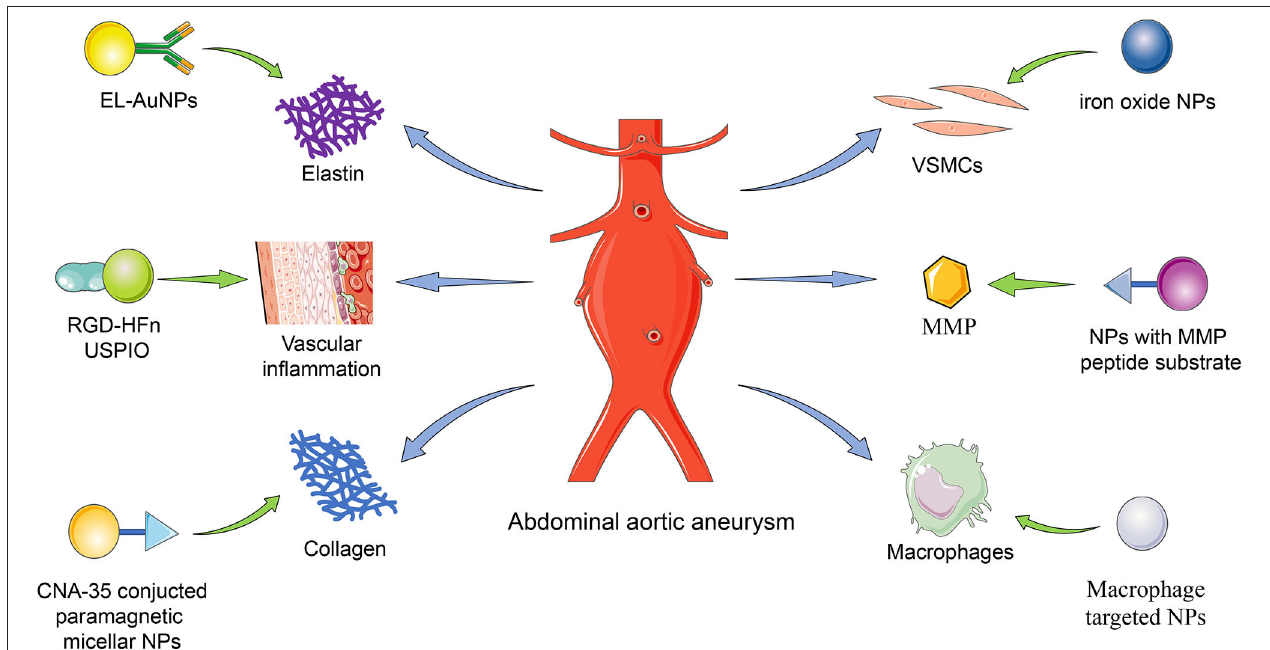
FIGURE 1 | The delivery targets of NPs. The nanoparticles were delivered to the AAA lesion targeting elastin, vascular inflammation, collagen, VSMCs, MMP, and macrophage. EL, elastin; NP, nanoparticle; AuNP, gold nanoparticle; RGD, Arg-Gly-Asp; HFn, human ferritin; USPIO, ultrasmall superparamagnetic particles of iron oxide; CAN-35, collagen-binding protein; VSMC, vascular smooth muscle cell; MMP, matrix